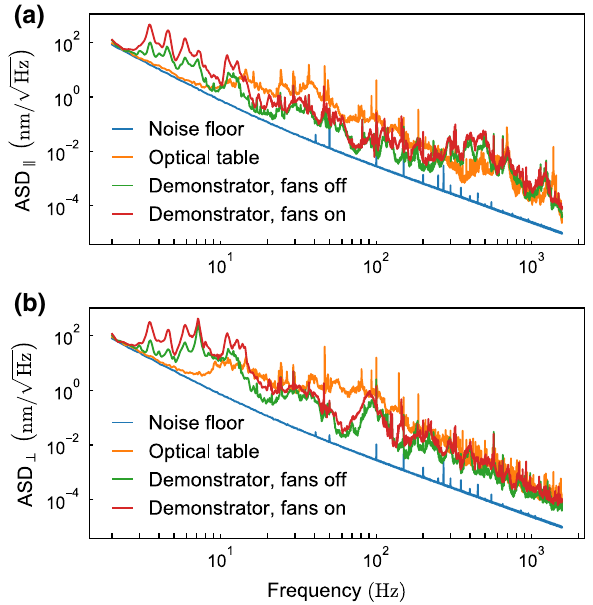
FIG. 10. Displacement (amplitude) spectral densities (ASDs) (a) parallel to the floor (horizontal) and (b) perpendicular to the floor (vertical) calculated from time series data obtained with piezoelectric shear accelerometers. Traces show equivalent dis- placement spectral densities of the electronic noise floor (blue), a typical optical table setup in close proximity (orange), and the demonstrator setup with cooling fans turned off (green) and on (red).